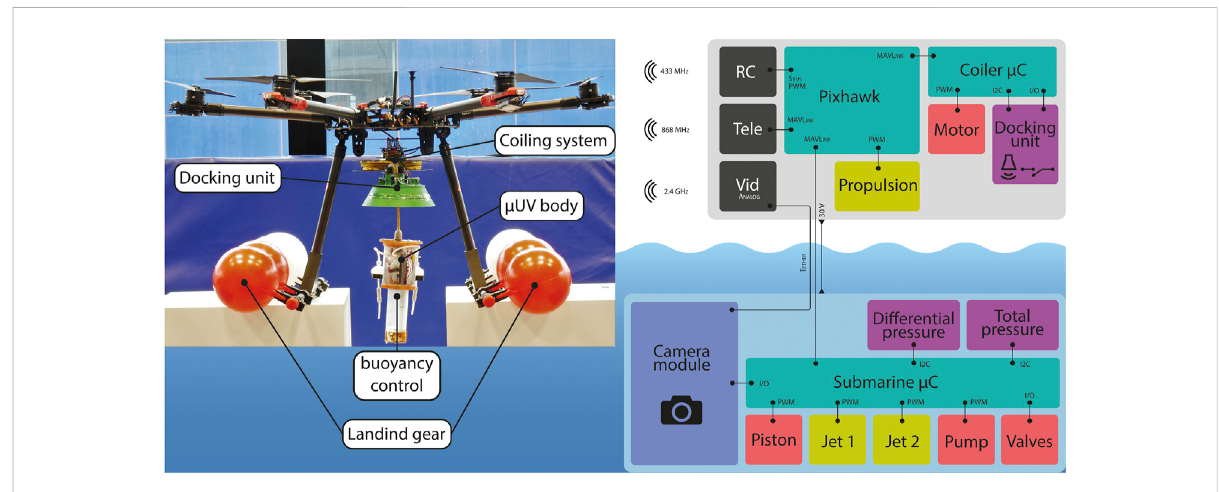
FIGURE 3 Principal mechanical subsystems that compose the MEDUSA system (left). On the left, electronics framework including: controllers, sensors, actuators and communication protocols for both the aerial (top) and underwater system